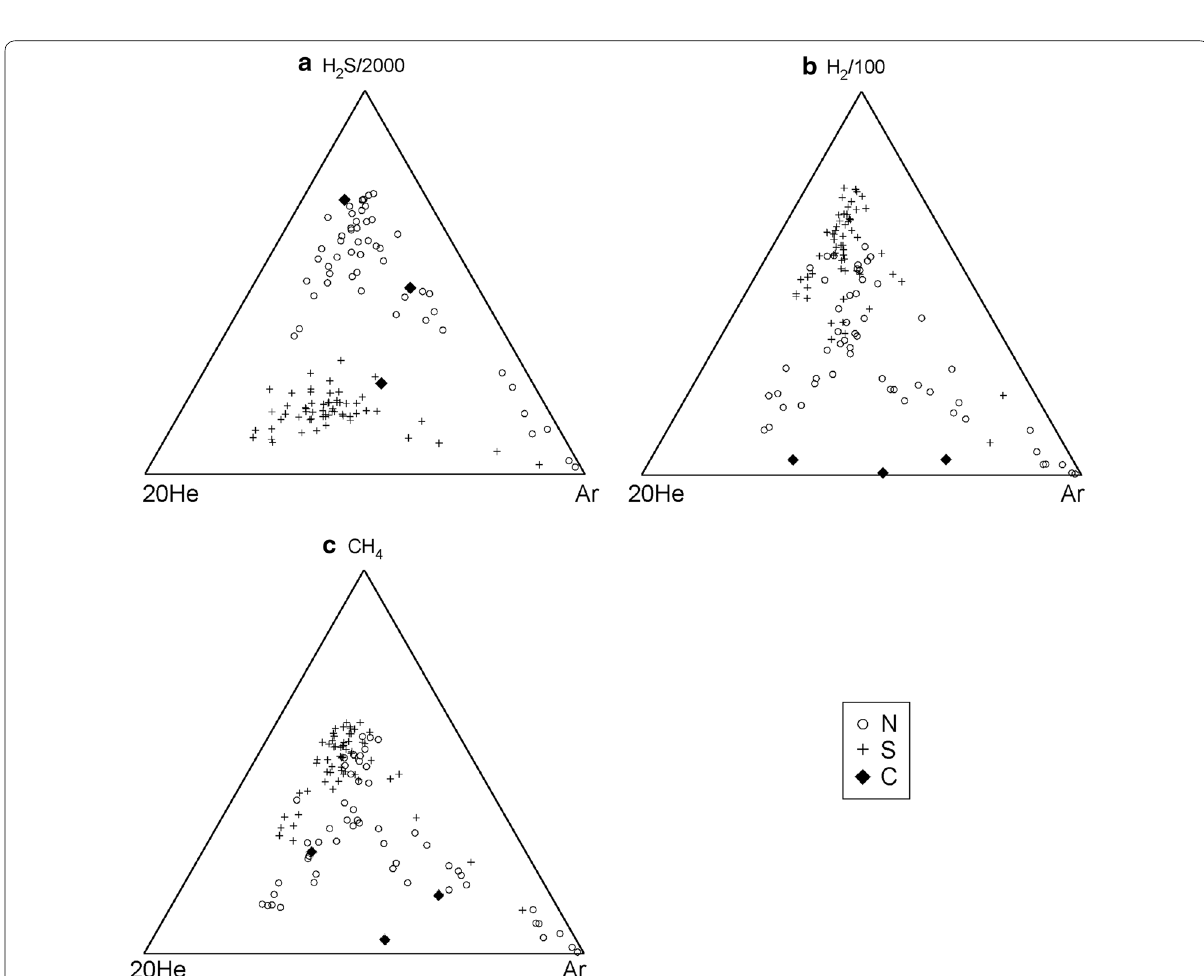
Fig. 6 Triangular diagrams for He–H 2 S–Ar ( a ), He–H 2 –Ar ( b ) and He–CH 4 –Ar ( c ) ternary